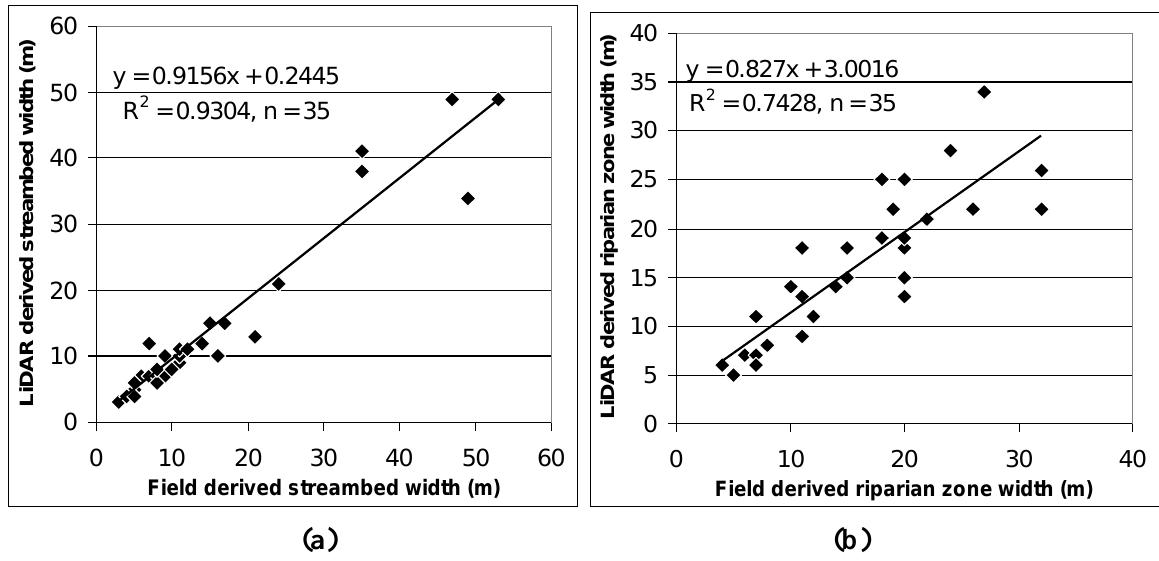
Figure 8. Scatter plots and trend lines comparing field and LiDAR derived (a) streambed width and (b) riparian zone width for 35 field sites. (a) RMSE = 3.6 m, P <